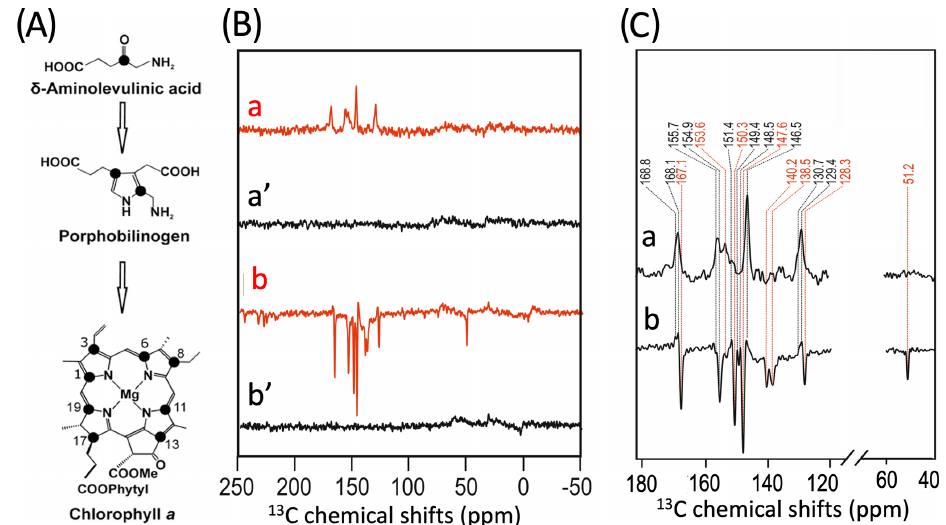
Figure 3. (A) Incorporation of [ 4 − 13 C ]− ALA into cofactors (e.g., Chl a ) of PS1-110 of duckweed. The black dots indicate the positions of 13 C isotopes. (B) 13 C photo-CIDNP MAS NMR spectra obtained under continuous illumination (red) of 4-ALA labeled PS1-110 particles of duckweed at a magnetic field strength of 4.7T (a) and 9.4T (b) . Spectra (a’, b’) depicted in black originate from the corresponding experiments obtained in the dark. (C) Enlarged view of 13 C photo-CIDNP MAS NMR spectra of 4-ALA-labeled PS1-110 particles of duckweed obtained at 4.7T (a) and 9.4T (b) . Assigned signals are shown by the dashed lines, and emissive signals are in red.